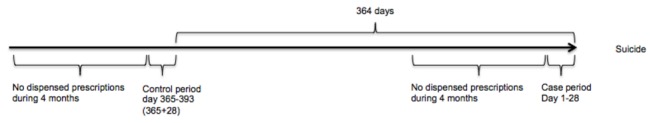
Graphical presentation of the definitions of case and control periods.